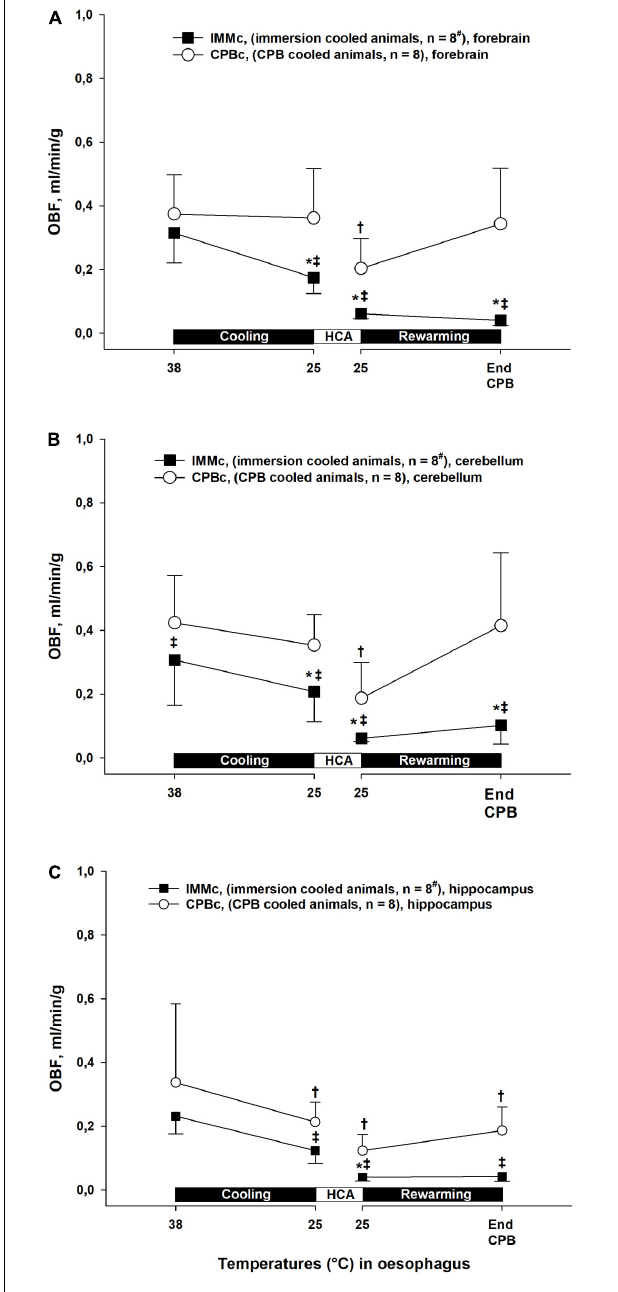
FIGURE 6 | Cerebral blood flow. (A) : forebrain, (B) : cerebellum, (C) : hippocampus. Data presented as mean and SEM. *Statistically significant difference from baseline within IMM c group, and † within CPB c group ( p < 0.05). ‡ Statistically significant difference between groups ( p < 0.05). # n was reduced to 5 animals after termination of CPB (Post CPB) and to 4 animals at end of experiments (End exp.) in IMM c